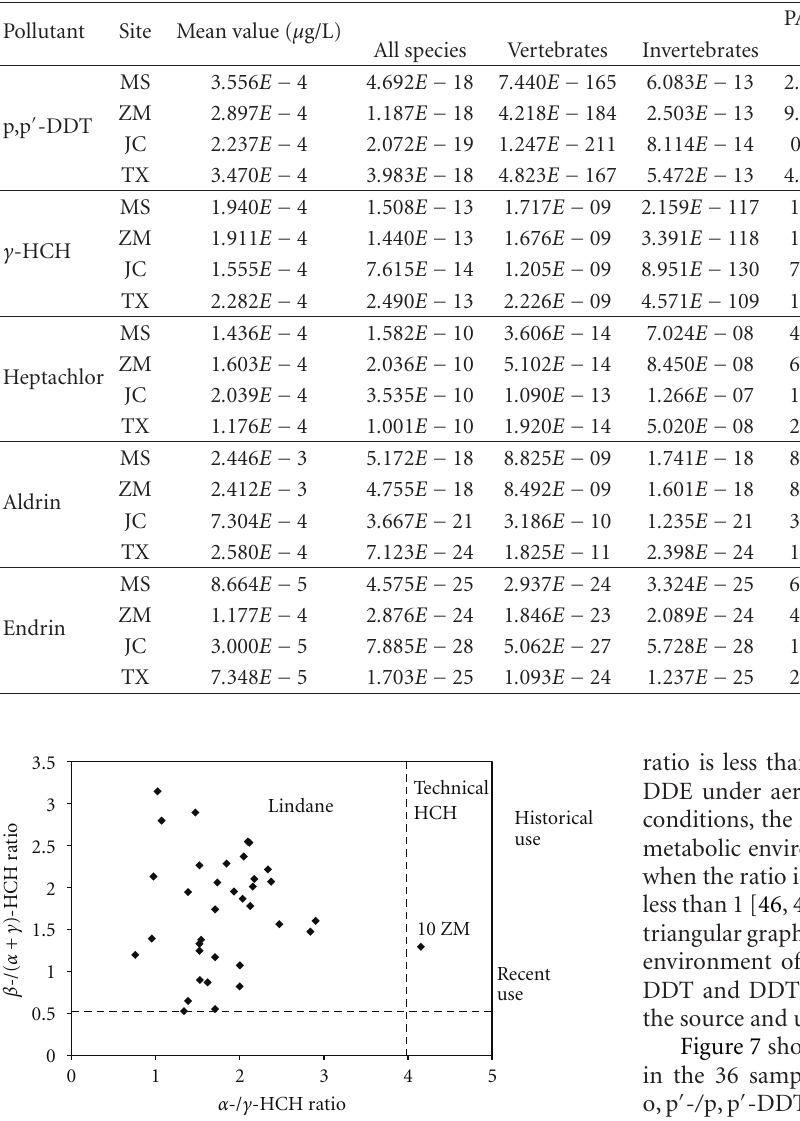
Table 6: The spatial variation of the mean ecological risk of typical OCPs (PAF).